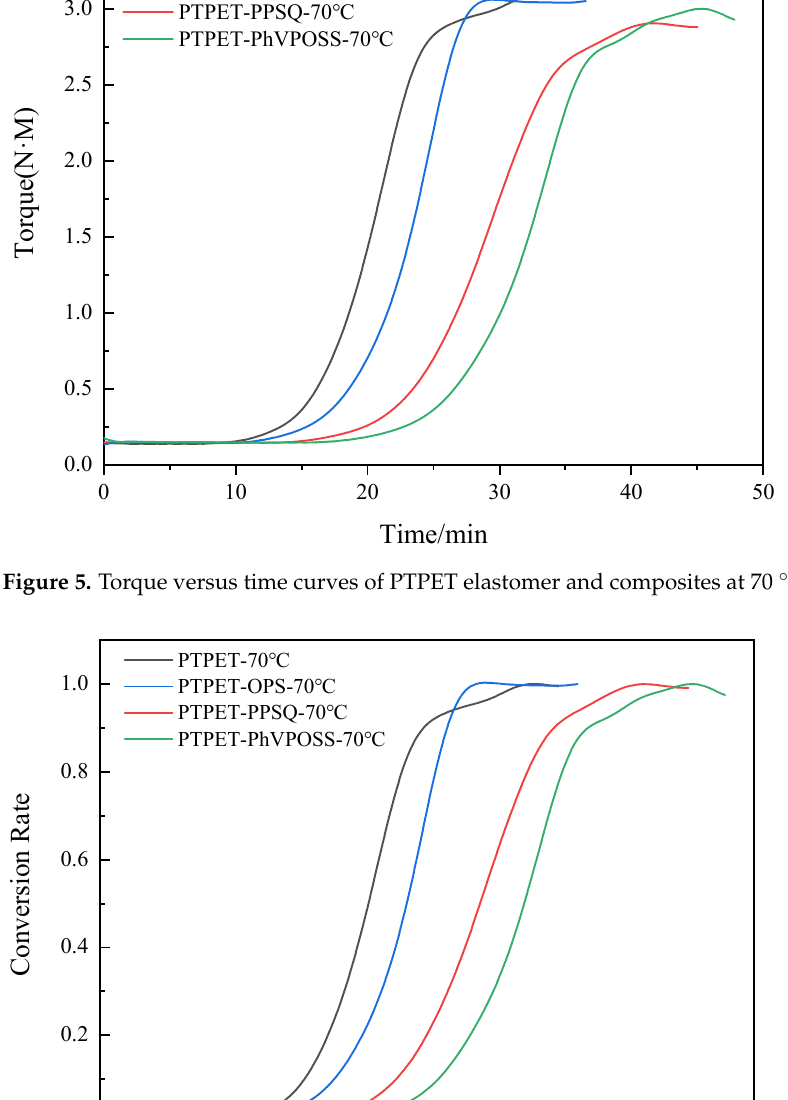
Figure 6. Conversion rate versus time curves of PTPET elastomer and composites at 70 °C.